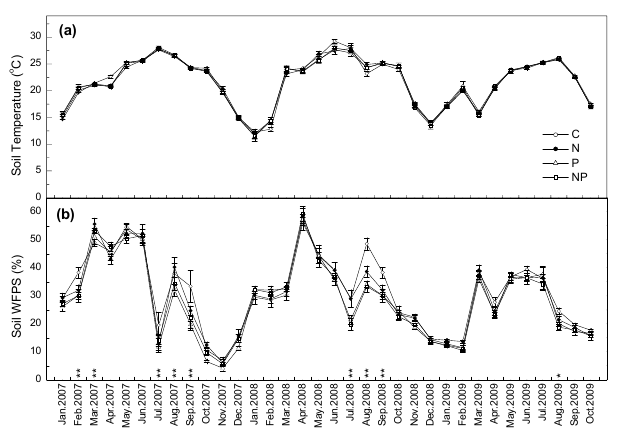
Fig. 2. Soil pH (a) , ammonia nitrogen (b) , available P (c) and total P (d) at 5cm depth in February 2007 and February 2009. Er- Figure 2. Soil pH ( a ), ammonia nitrogen ( b ), available P ( c ) and total P ( d ) at 5cm ror bars represent standard error of means (N=5). Different letters depth in Feb. 2007 and Feb. 2009. Error bars represent standard error of means (N = denote significant difference ( p < 0 . 05) between treatments by the 5). Different letters denote significant difference ( p < 0.05) between treatments by the Repeated Measurement Repeated Measurement ANOVA.